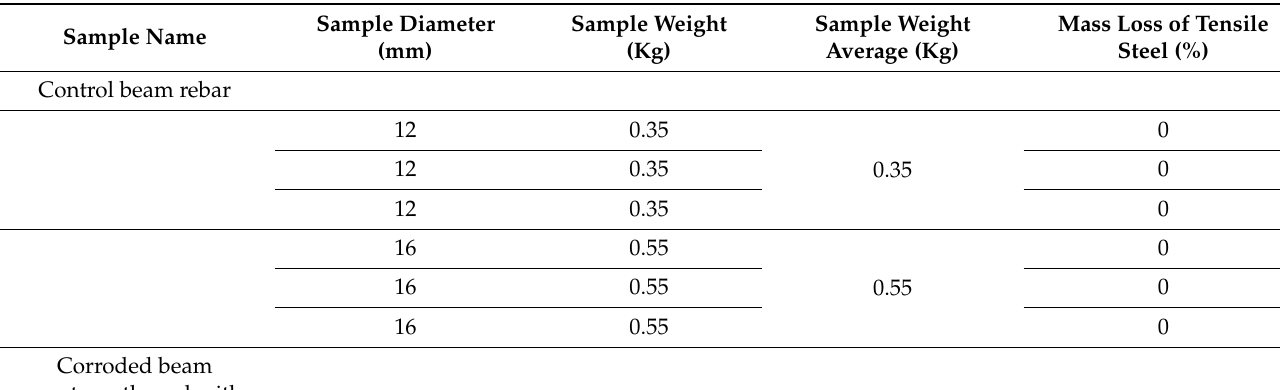
Table 3. Steel reinforcement sample weight and mass